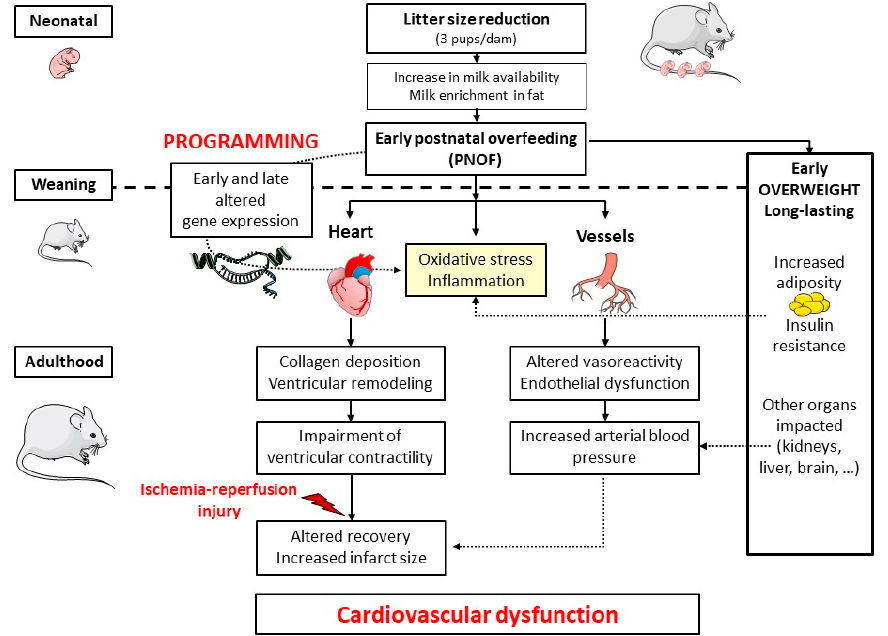
Figure 1. Cardiac and vascular consequences of neonatal programming by postnatal overfeeding (PNOF) in rodents. PNOF can be induced by litter size reduction, a situation that increases milk consumption during the 24 days after birth and leads to early and long-lasting obesity. Additionally, the expression of several genes is modified in many organs, leading to structural and metabolic alterations. Cardiovascular consequences appear later in life, including altered vasoreactivity and increased arterial blood pressure, ventricular remodelling, cardiac oxidative stress and inflammation, and impaired cardiac contractility and architecture. Altogether, these modifications are responsible for an increased sensitivity to ischemia-reperfusion injury and cardiovascular dysfunction in